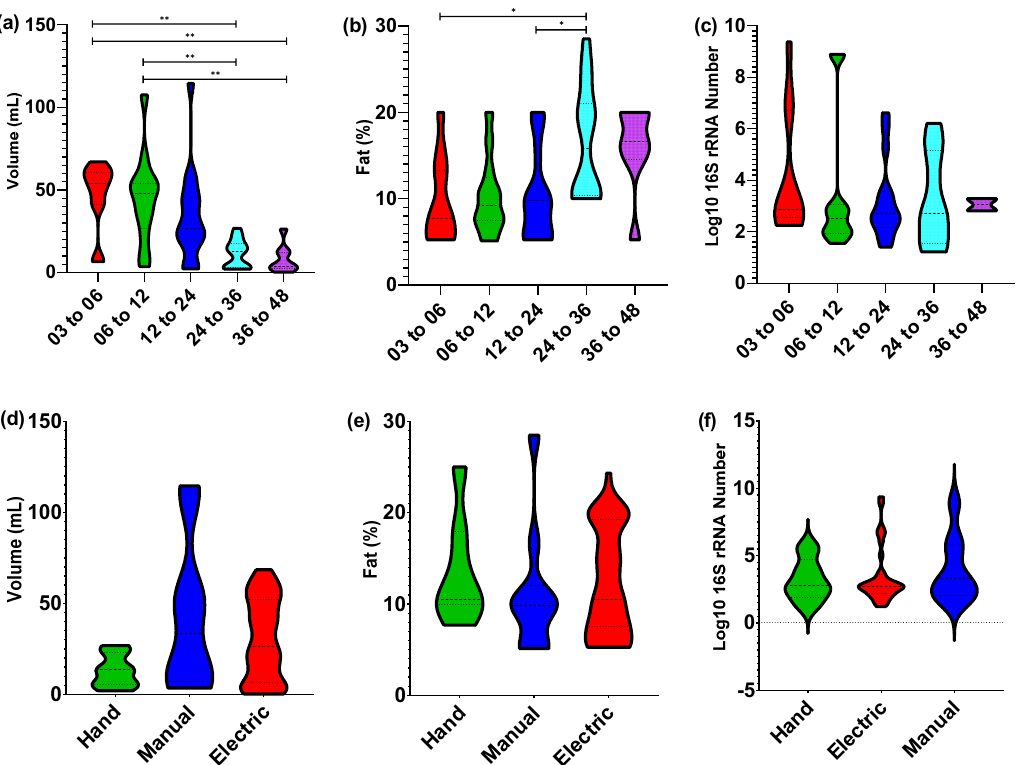
Figure 1. Nursling age and expression method e ff ects volume but not fat or bacterial load of milk. Total expressed volume of human milk for ( a ) age groups and ( b ) milk expression method; total fat percentage—0% to 100%—of human milk for ( c ) age groups and ( d ) milk expression method; and Log 10 of 16S rRNA gene copy number as a measure of total bacterial count for ( e ) age groups and ( f ) milk expression method. All datasets show a non-normal distribution based on an Anderson–Darling normality test with p value less than 0.05. Only significantly di ff erent groups ( p value less than 0.05), as determined by a Kruskal–Wallis test, were used with a p value threshold of less than 0.05 with class di ff erences identified using a post hoc Dunn’s multiple comparisons test with an adjusted p value threshold of less than 0.05. p value significance thresholds identified as * < 0.05, ** < 0.01. A total of 62 human milk replicates were used for expressed volume and fat percentage comparisons, and 49 for Log 10 of 16S rRNA number